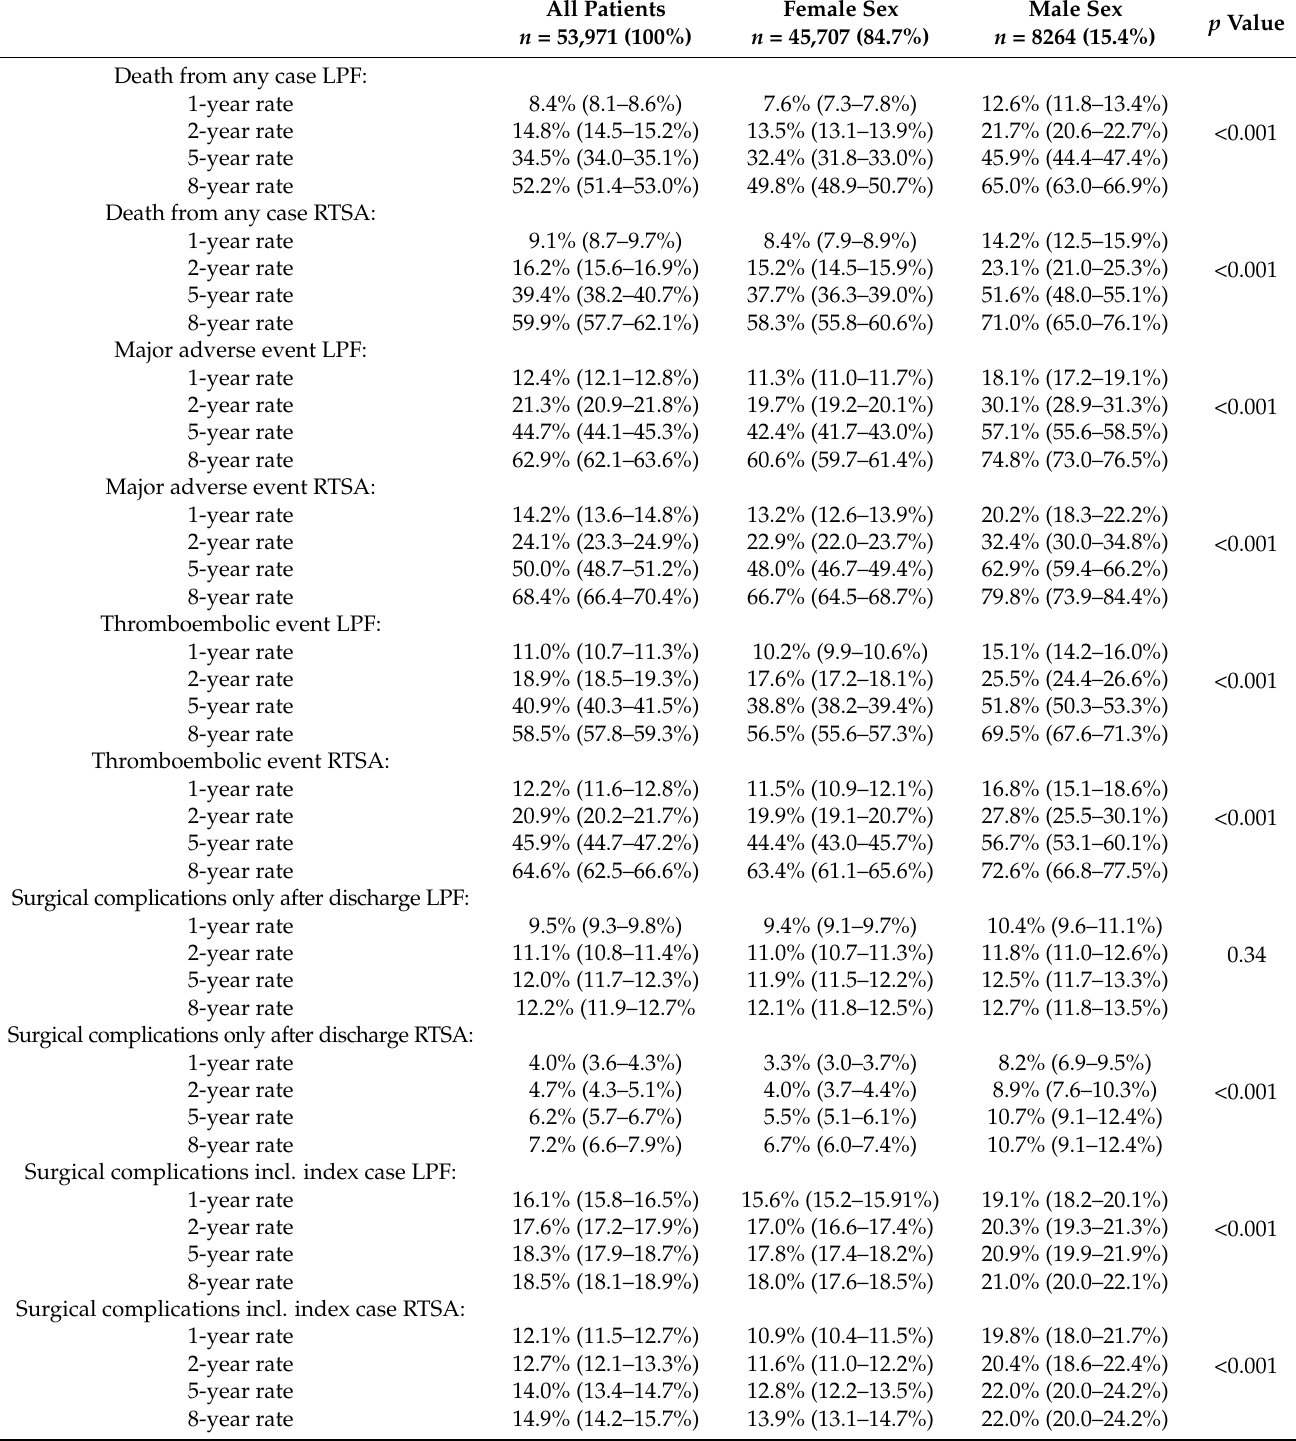
Table 1. Cumulative incidence function/event rates of primary outcomes and 95% confidence intervals depending on sex and treatment